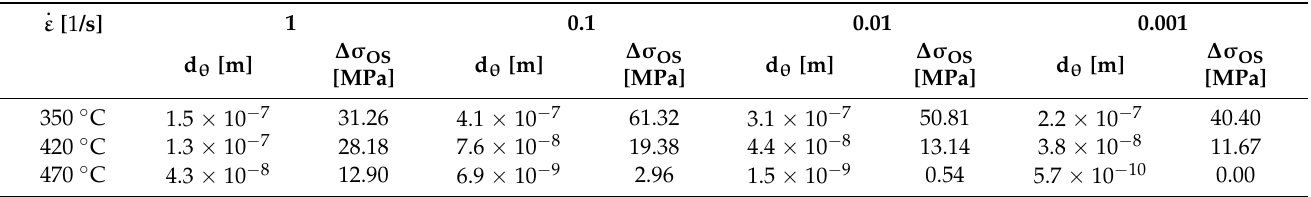
Table A2. Fitted Feret diameter of θ -Al 2 Cu particles and the resulting Orowan strength contribu- tion ∆ σ OS